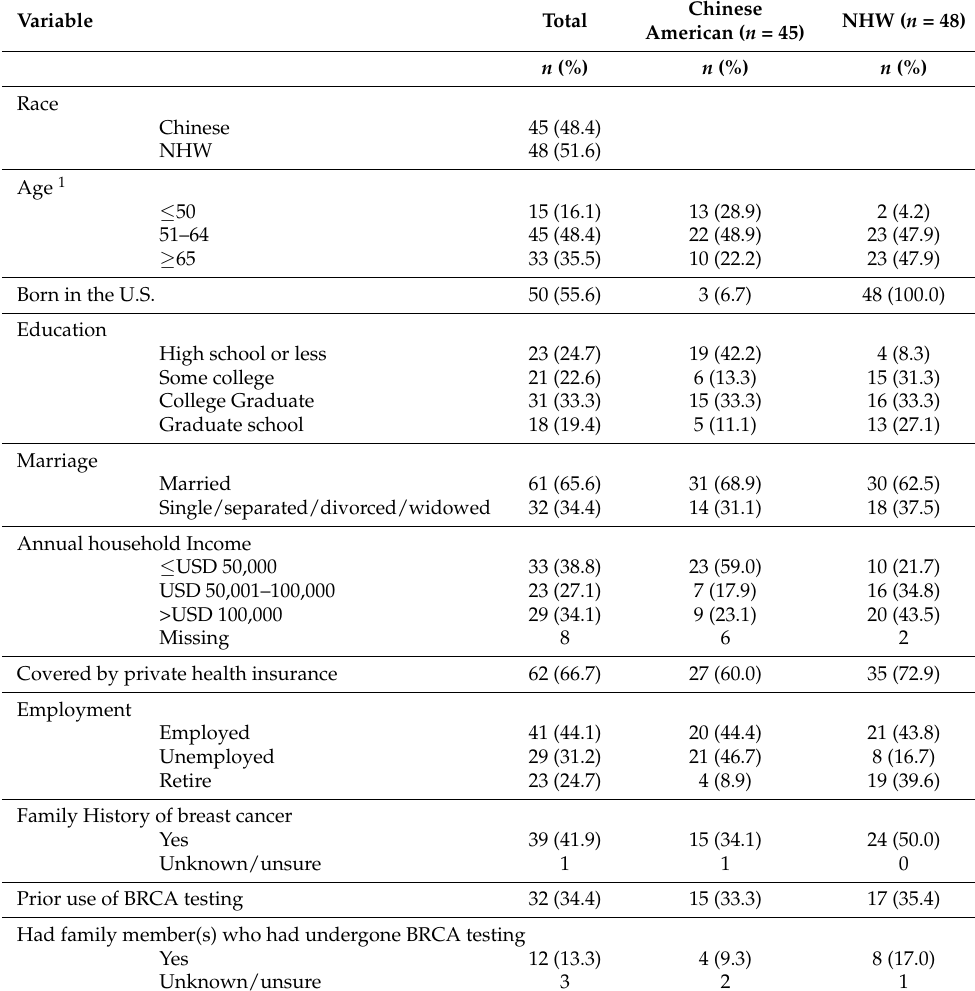
Table 1. Participant